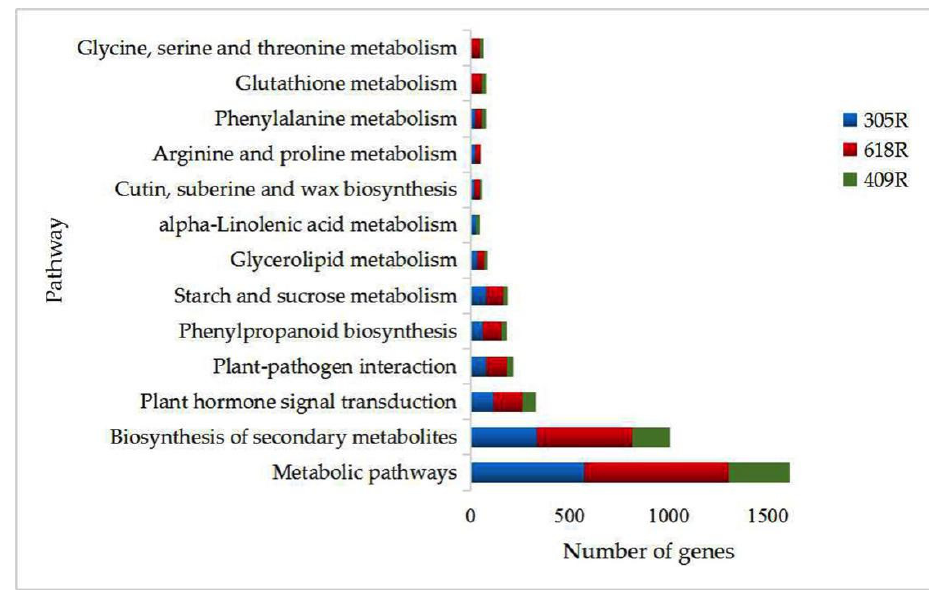
Figure 3. Pathways of 305R, 618R, and 409R enriched in biological processes.